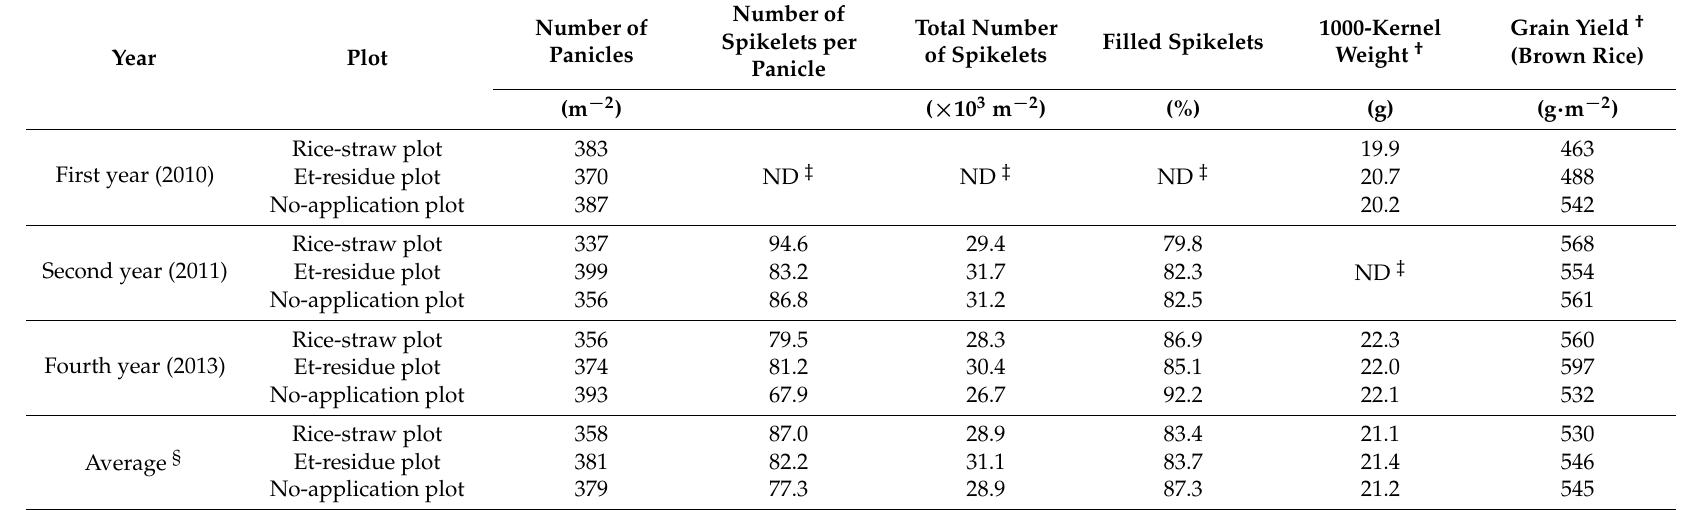
Table 2. Grain yield and yield component for three